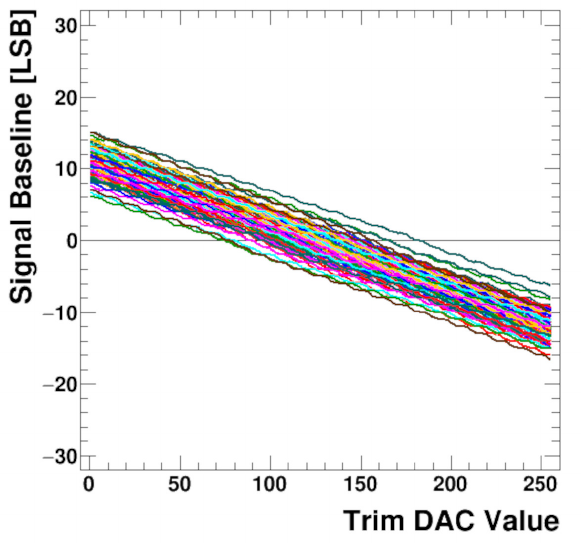
Figure 11. Baseline trim Digital-to-Analog Converters (DACs) scan for 128 channels before sen- sor connection.